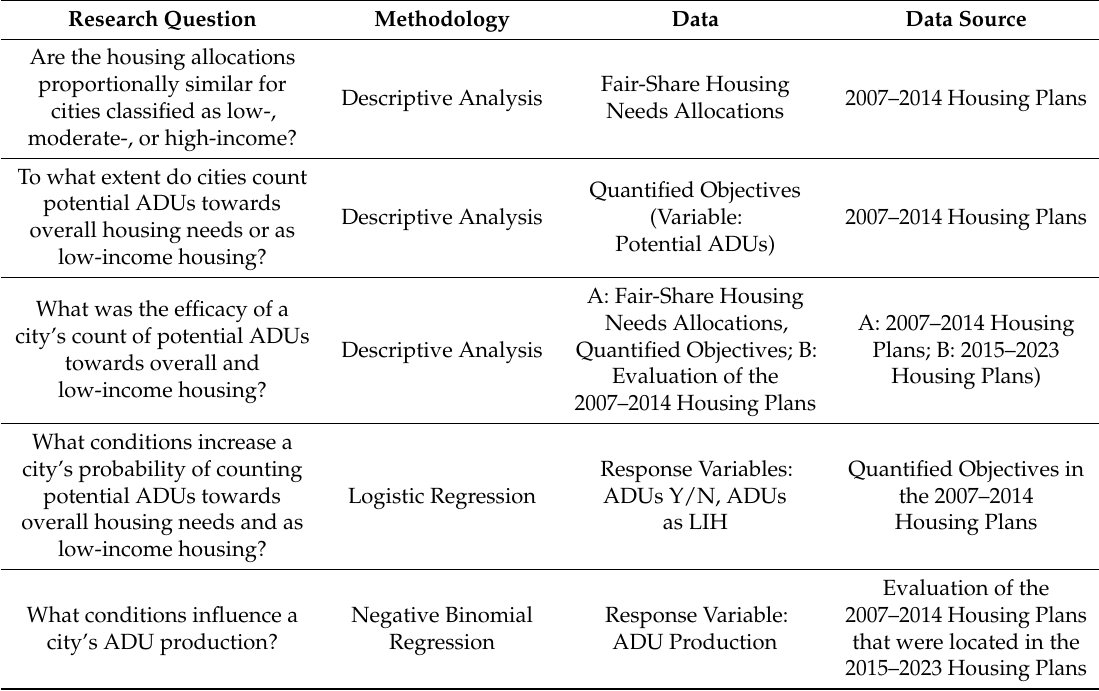
Table 2. The study employs five research questions and the table lists of the research questions, methodology, data, and primary data sources. Notes: ADU = accessory dwelling unit, LIH = low-income housing, Y/N = yes or